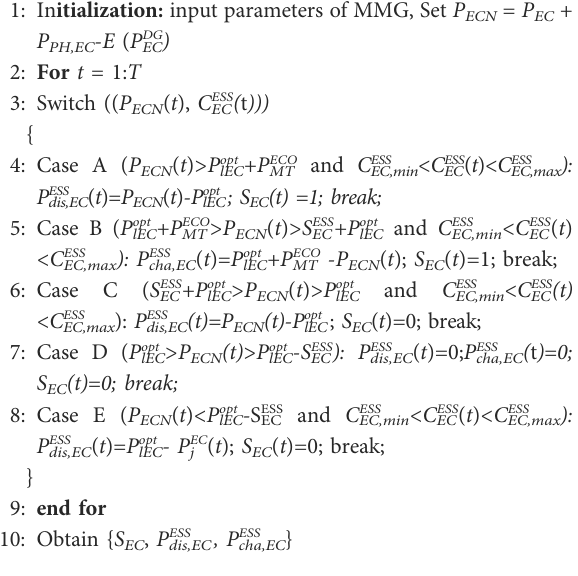
Algorithm 1. Constant power interaction